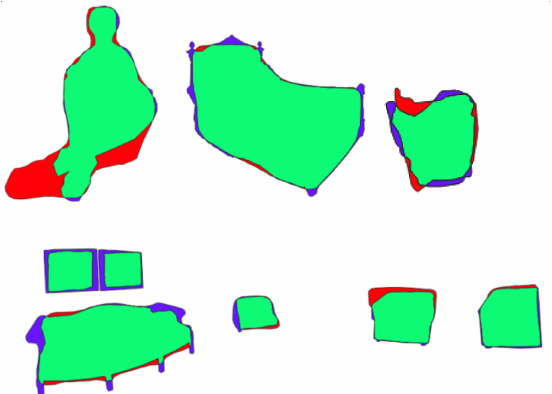
Figure 29. Examples of the adopted method to calculate quality measures. Blue, red, and green colour represent FN, FP, and TP,